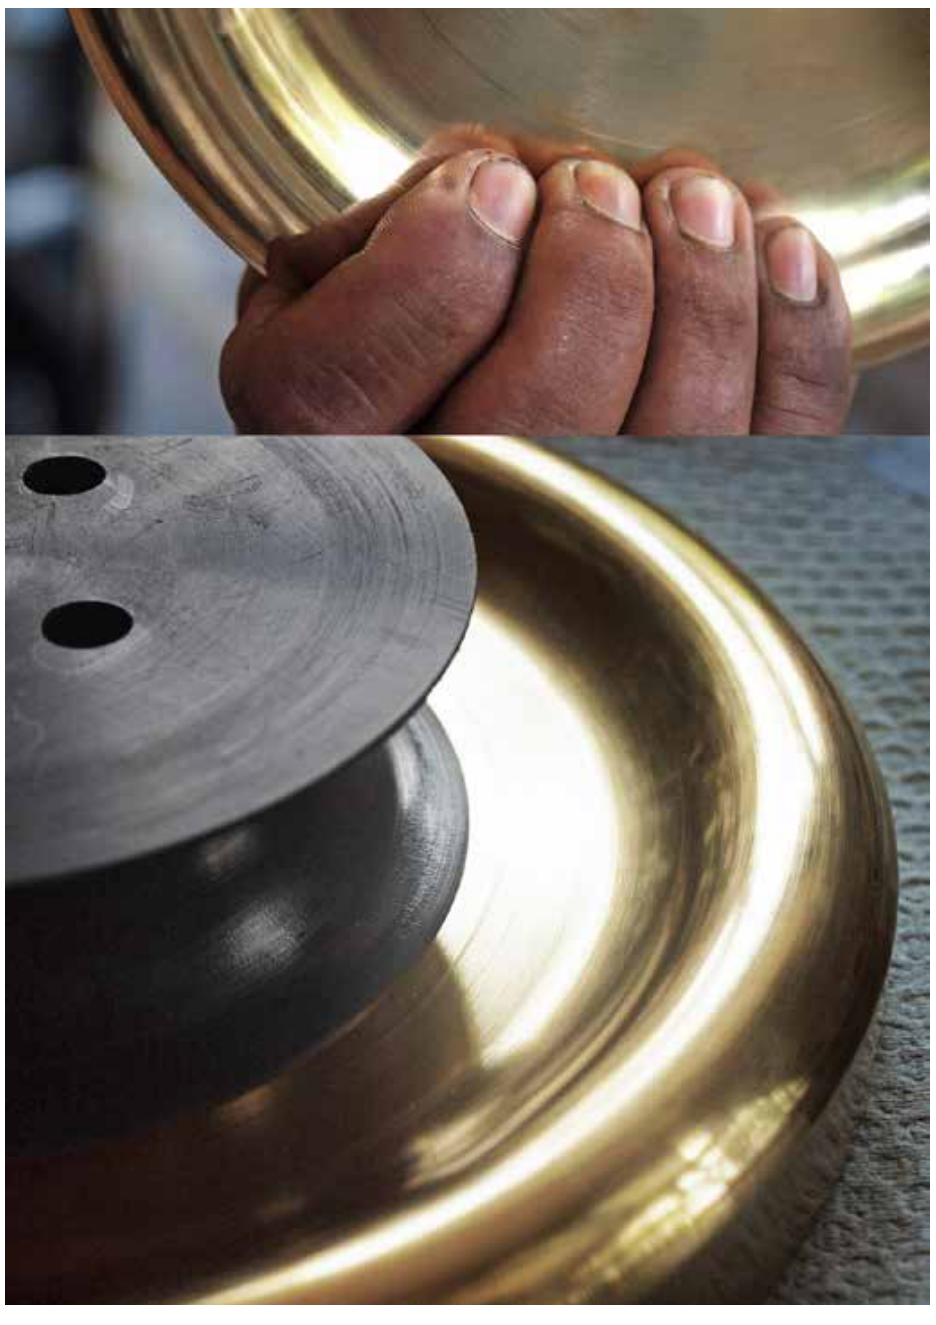
Figure 10: Traces of wear. A backside lip for fingers on a brass door handle. Source: